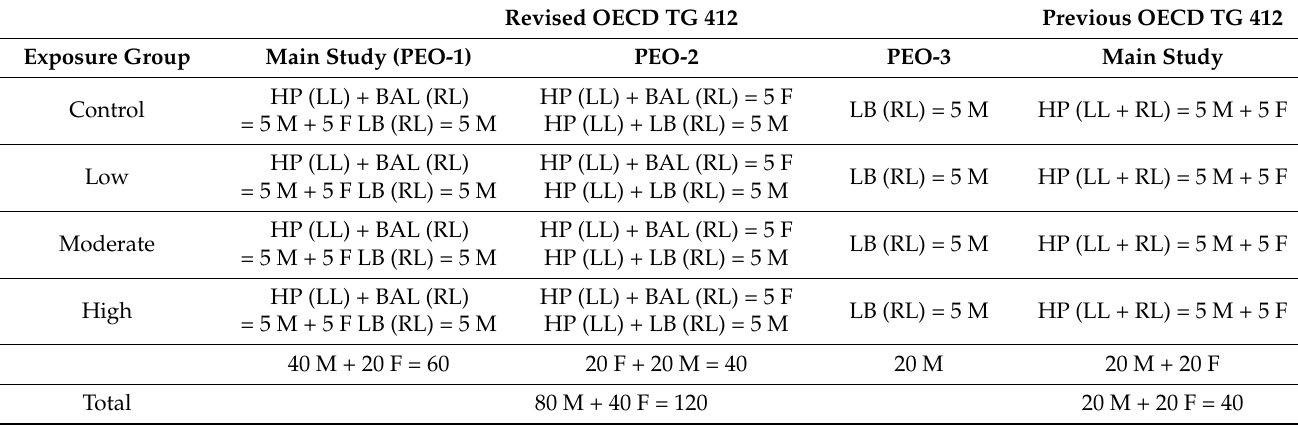
Table 1. Study design for TG